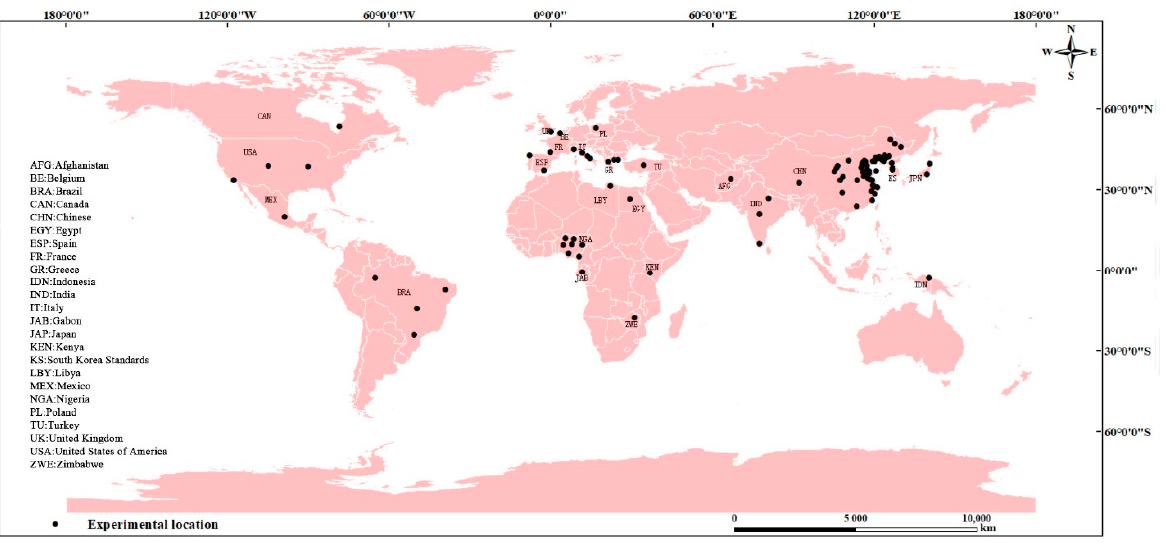
Figure 1. Geographic distribution of the experimental sites in this meta-analysis.